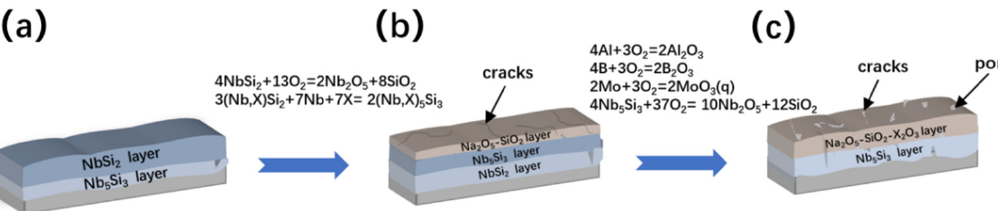
Figure 12. Oxidation and failure mechanism of silicide coatings on Nb-based alloys, ( a ) Before coating oxidation; ( b )Primary oxidation of coating; ( c ) Deep oxidation of coating.